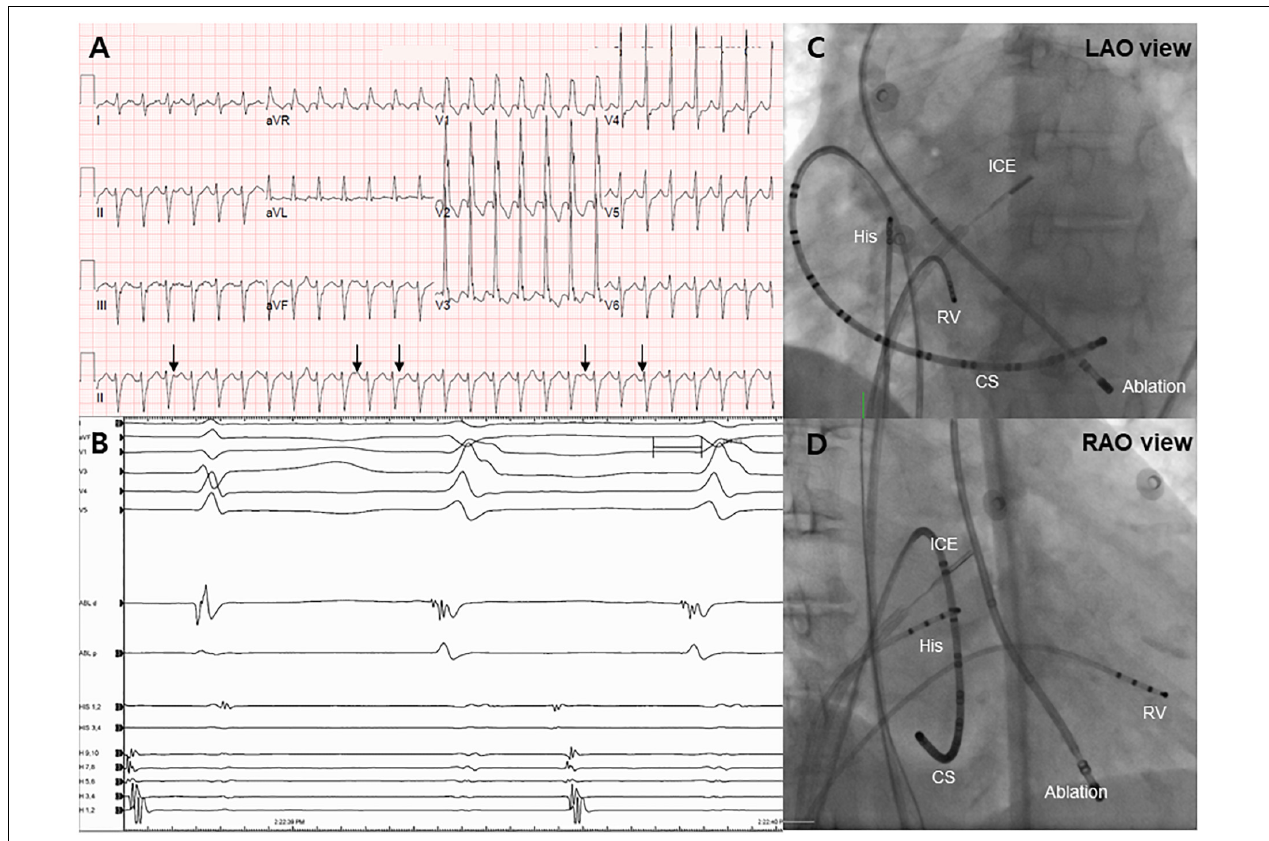
FIGURE 1 | Electrocardiogram and endocardial mapping. (A) Electrocardiogram of monomorphic ventricular tachycardia showing ventriculoatrial dissociation (black arrows). (B) Intracardiac electrogram revealing an early signal ( − 40 ms) before the QRS complex during the ventricular tachycardia rhythm. (C,D) Right and left anterior oblique projections of endocardial mapping using intracardiac echocardiography. CS, coronary sinus; RV, right